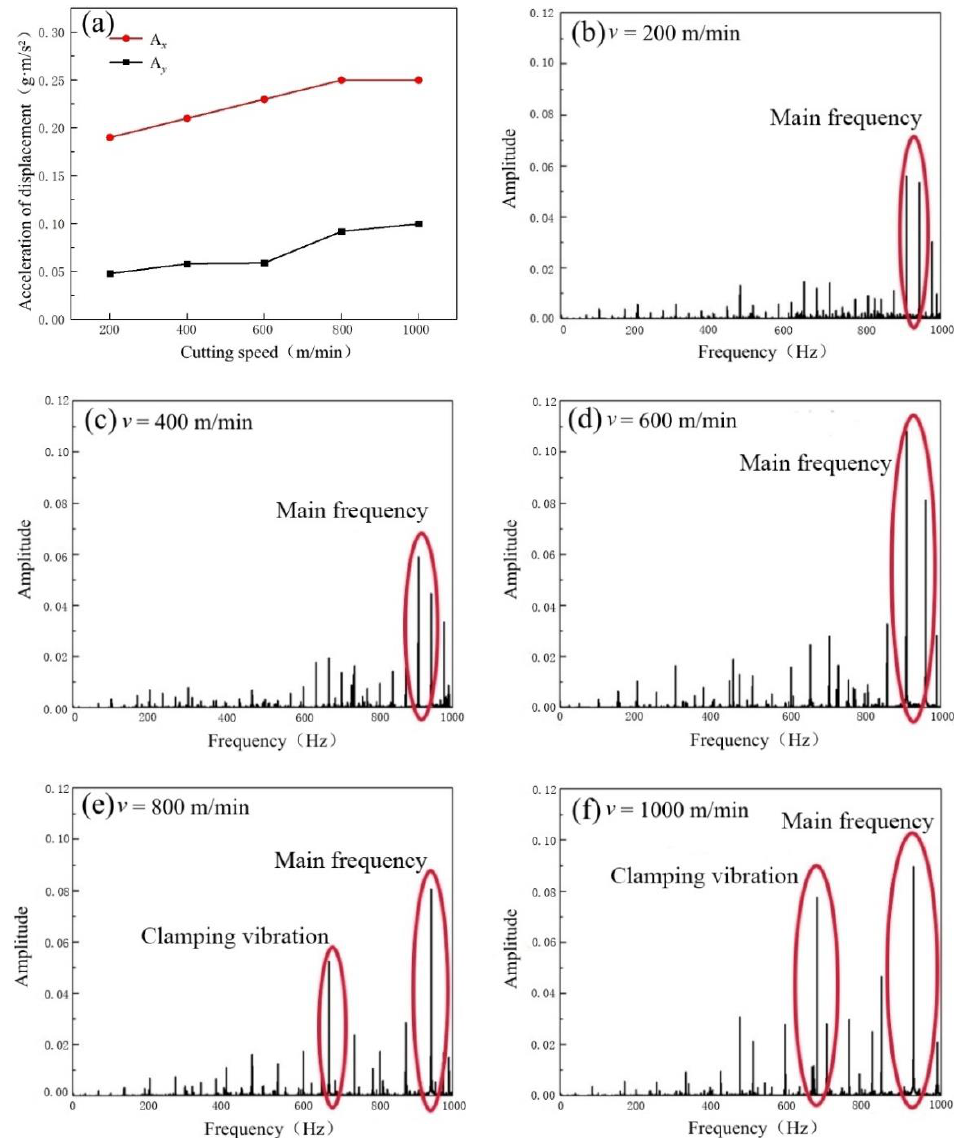
Figure 13. ( a ) Variation trends of displacement acceleration at different cutting speeds. The fre- quency domain distribution of tool-moving direction: ( b ) v = 200 m/min; ( c ) v = 400 m/min; ( d ) v = 600 m/min; ( e ) v = 800 m/min; ( f ) v = 1000 m/min.